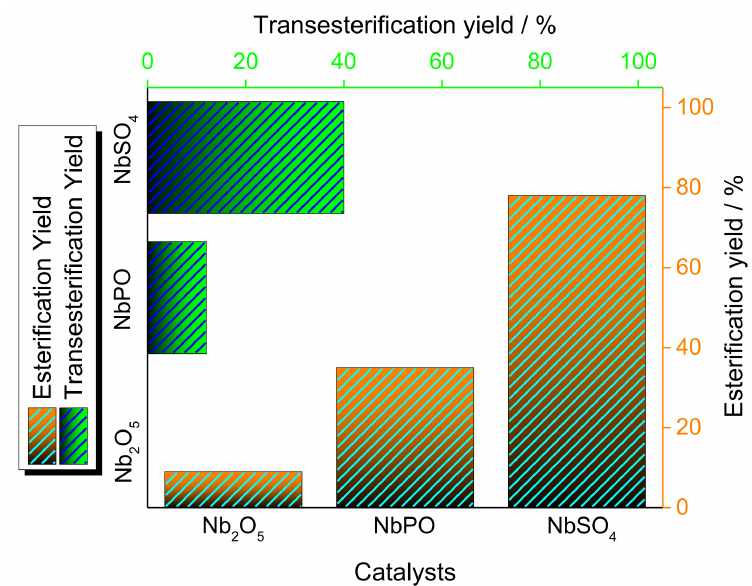
Figure 38. Esterification and transesterification yields catalyzed by Niobium catalysts in methanol. Reaction conditions: soybean oil (12.00 g), oleic acid (4.00 g), methanol (7.00 mL), catalyst (0.30 g), temperature (70 ◦ C), time (5 h) (adapted from